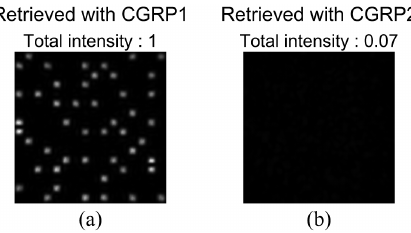
Figure 10. Intensity distributions of a reconstructed beam from a volume hologram of the data page 1 by illuminating with ( a ) CGRP1 and ( b )